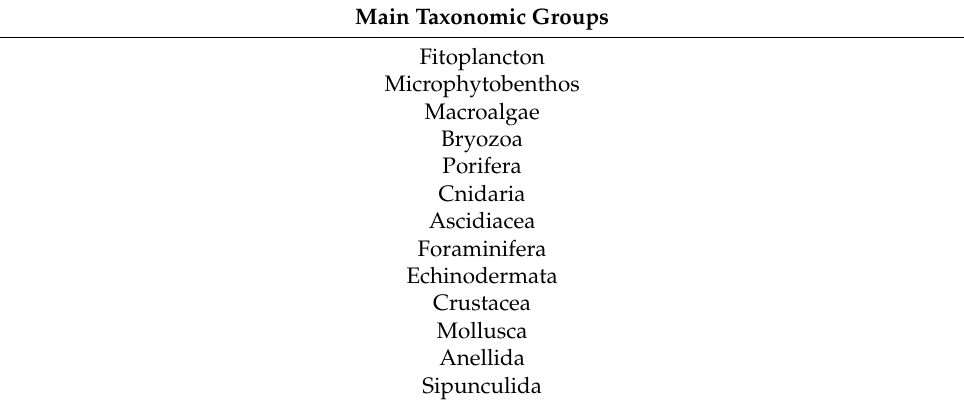
Table A1. List of the main taxonomic groups selected in literature [33,60–80] for the emergy application.